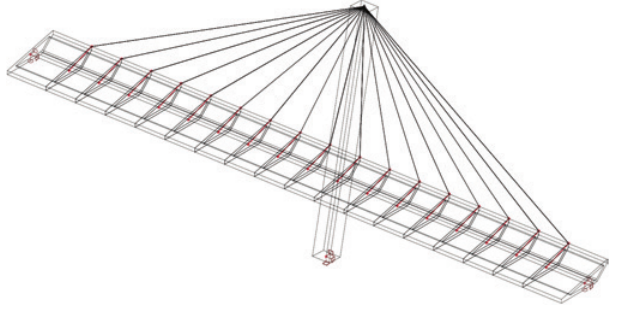
Figure 18 to 25 present shear and moments diagrams of the curved deck suspended by the outer side.